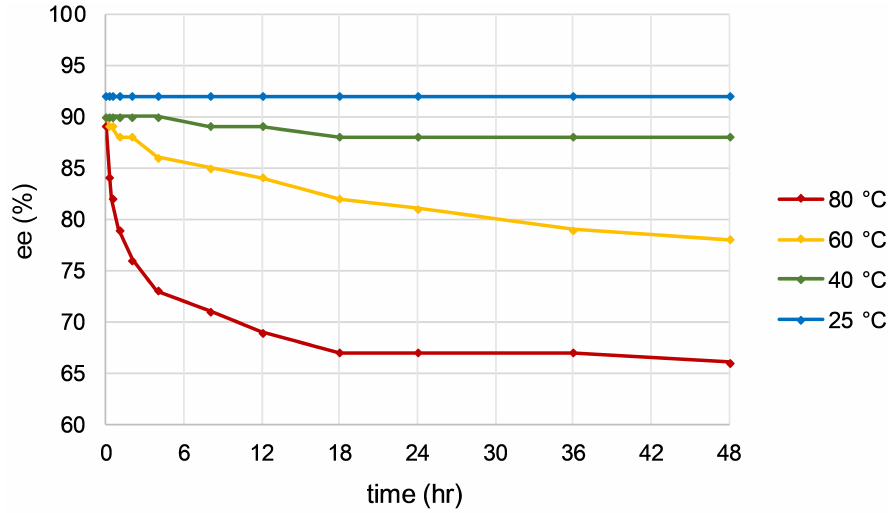
Figure 10. Enantiomeric excess of 1-phenylethanol over time at various temperatures. Enantioselectivity degraded over time at temperatures above 25